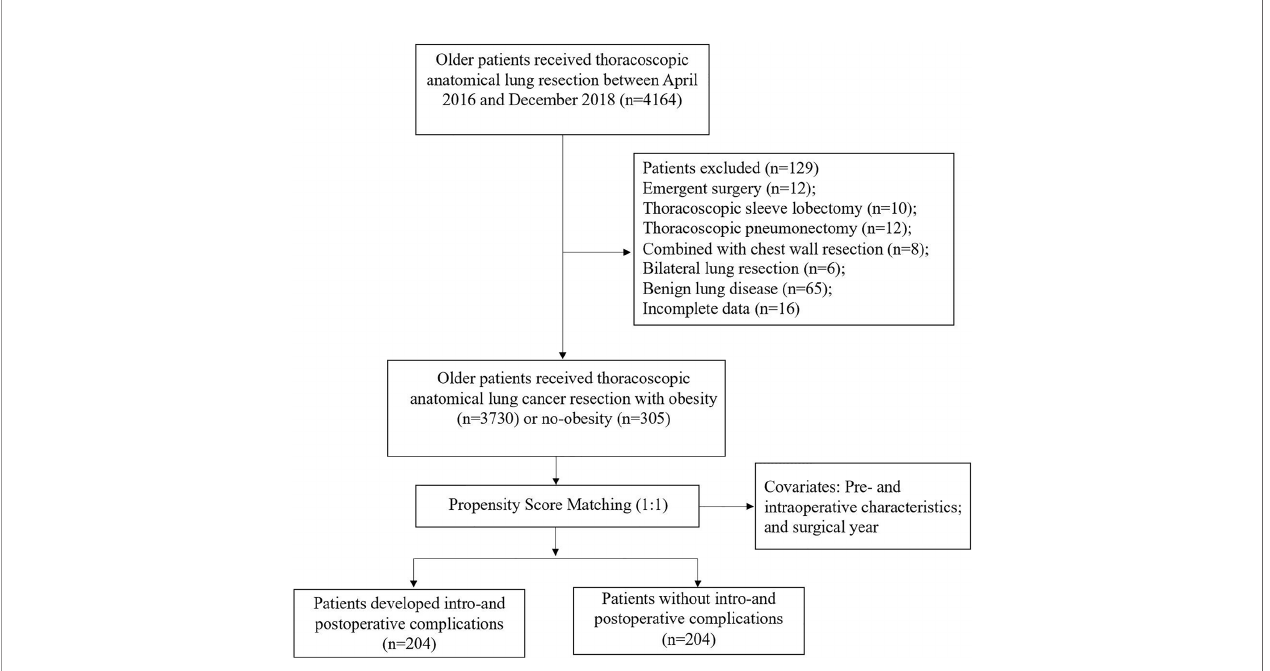
FIGURE 1 | Patient fl